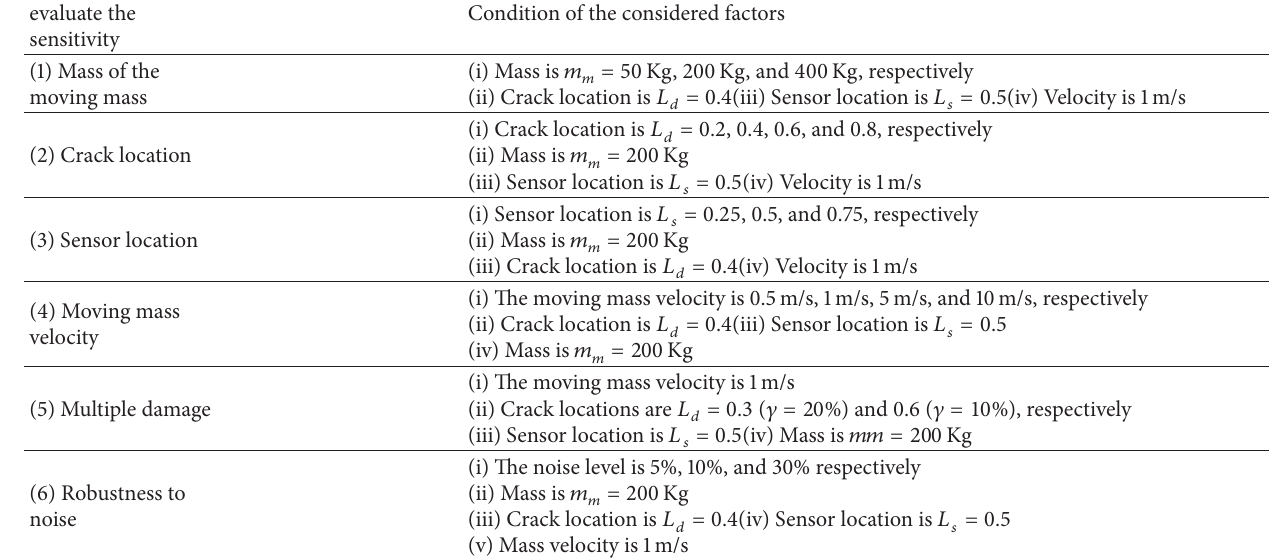
Table 1: Analysis